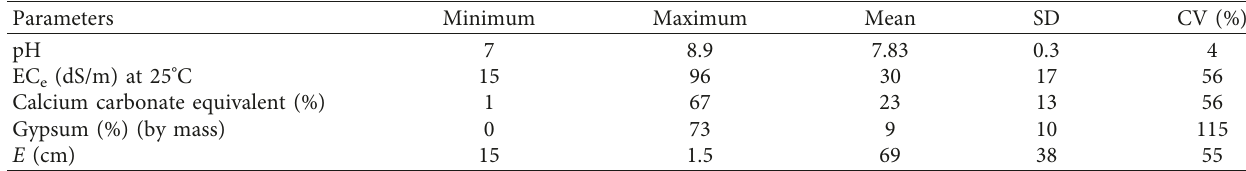
Table 1: Characteristics of diagnostic horizons of studied Solonchaks.